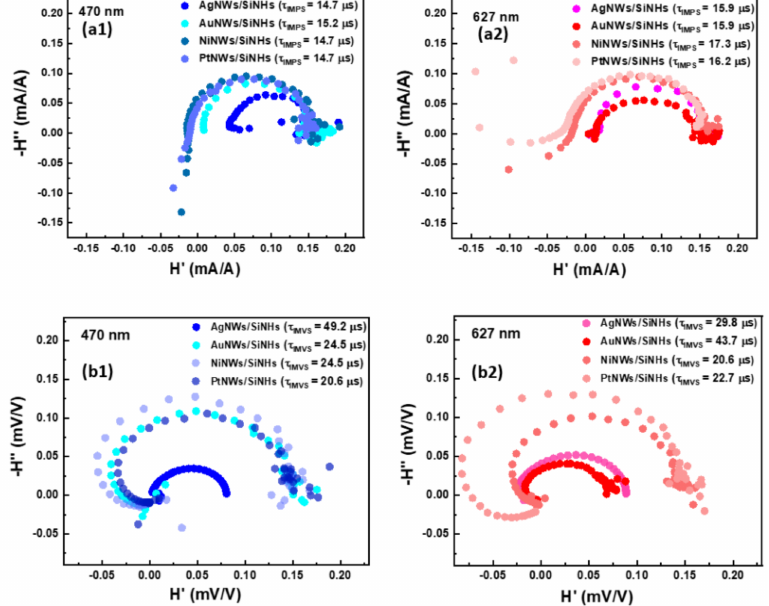
Figure 8. ( a1 , b1 ) IMPS and IMVS responses in the complex plane at 470 nm and ( a2 , b2 ) at 627 nm